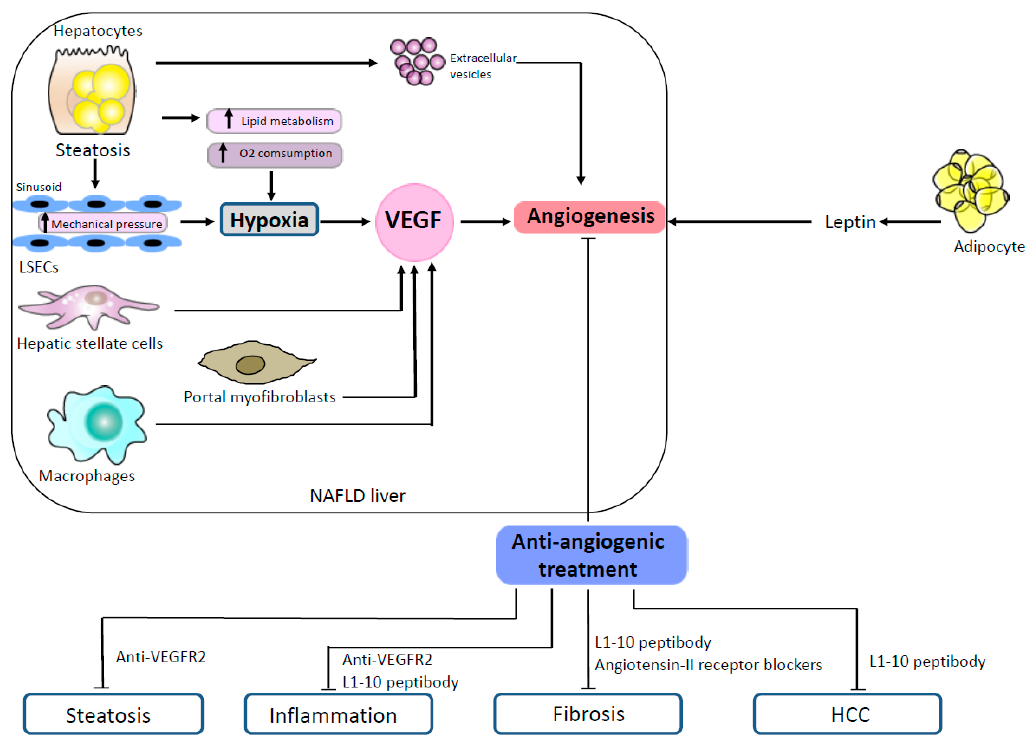
Figure 1. Mechanisms promoting angiogenesis in NAFLD and effects of antiangiogenic treatments in animal models. In NAFLD, steatotic hepatocytes produce proangiogenic extracellular vesicles. Steatosis induces hypoxia both by an increased lipid metabolism which enhances oxygen consumption and by a mechanical pressure on sinusoids. Hepatic stellate cells, portal myofibroblasts and macrophages stimulate angiogenesis by secreting VEGF. Proangiogenic signals also come from the adipose tissue which secretes leptin. In animal models of NAFLD, several antiangiogenic treatments (anti-VEGR2, L1-10 peptibody, angiotensin II receptor blockers) have shown efficacy to reduce steatosis, inflammation, fibrosis and HCC. Abbreviations: HCC, hepatocellular carcinoma; LSECs, liver sinusoidal endothelial cells; NAFLD, non-alcoholic fatty liver disease; VEGF, vascular endothelial growth factor; VEGFR-2, vascular endothelial growth factor